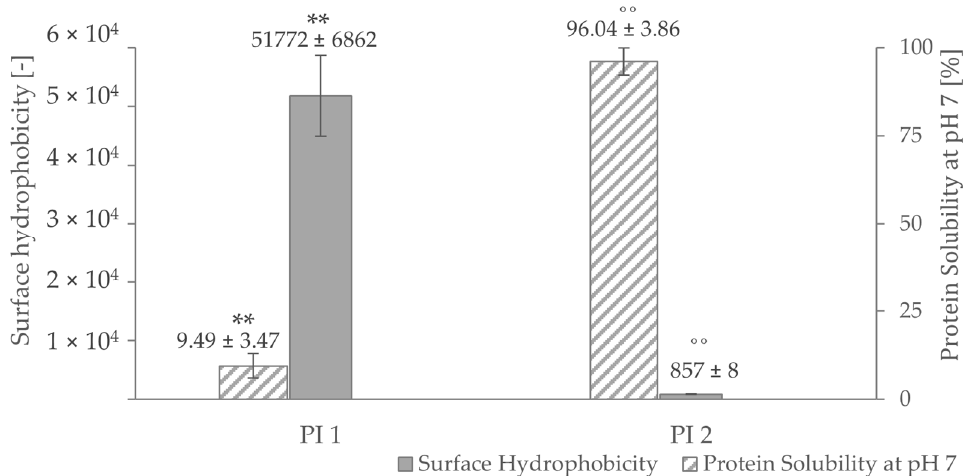
Figure 3. Protein solubility and surface hydrophobicity at pH 7 of the protein isolates PI 1 and PI 2. ** negative correlation with a Pearson correlation coefficient of r = 0.81 ( p < 0.05). ˚˚ negative correlation with a Pearson correlation coefficient of r = 1.00 ( p < 0.05).